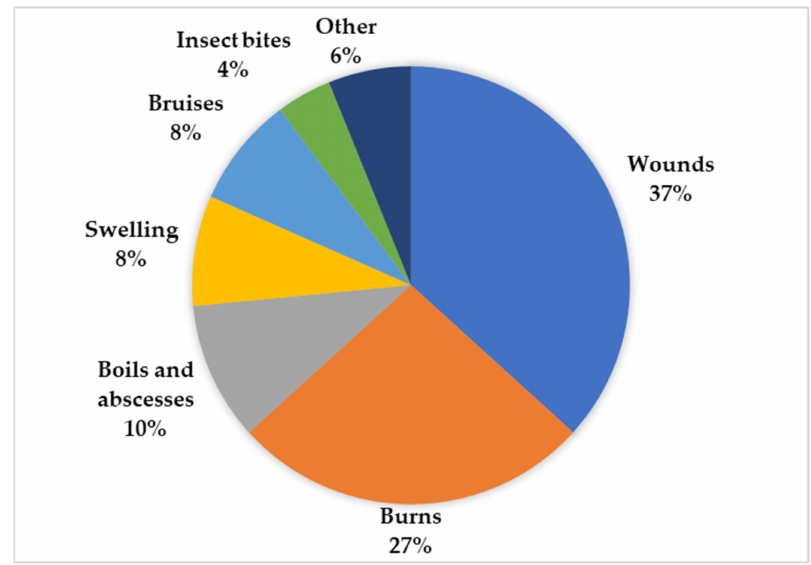
Figure 3. Topical uses of bryophytes for skin